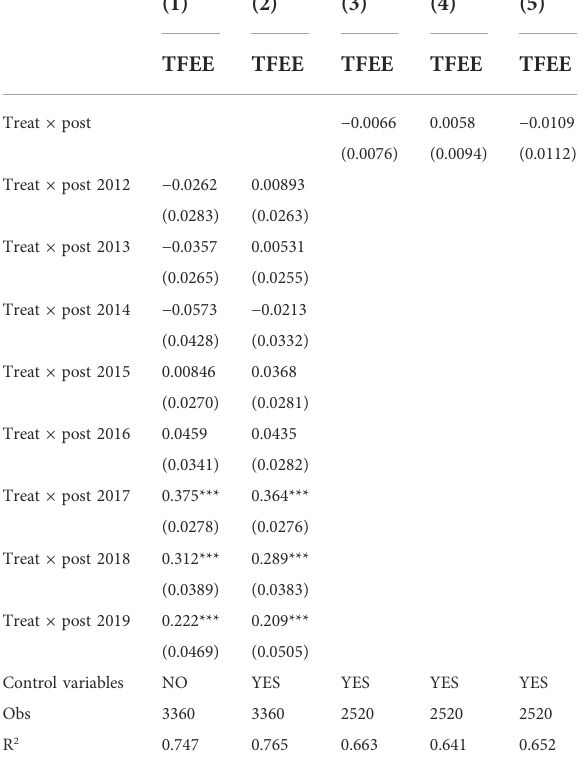
TABLE 3 Parallel trend and counterfactual